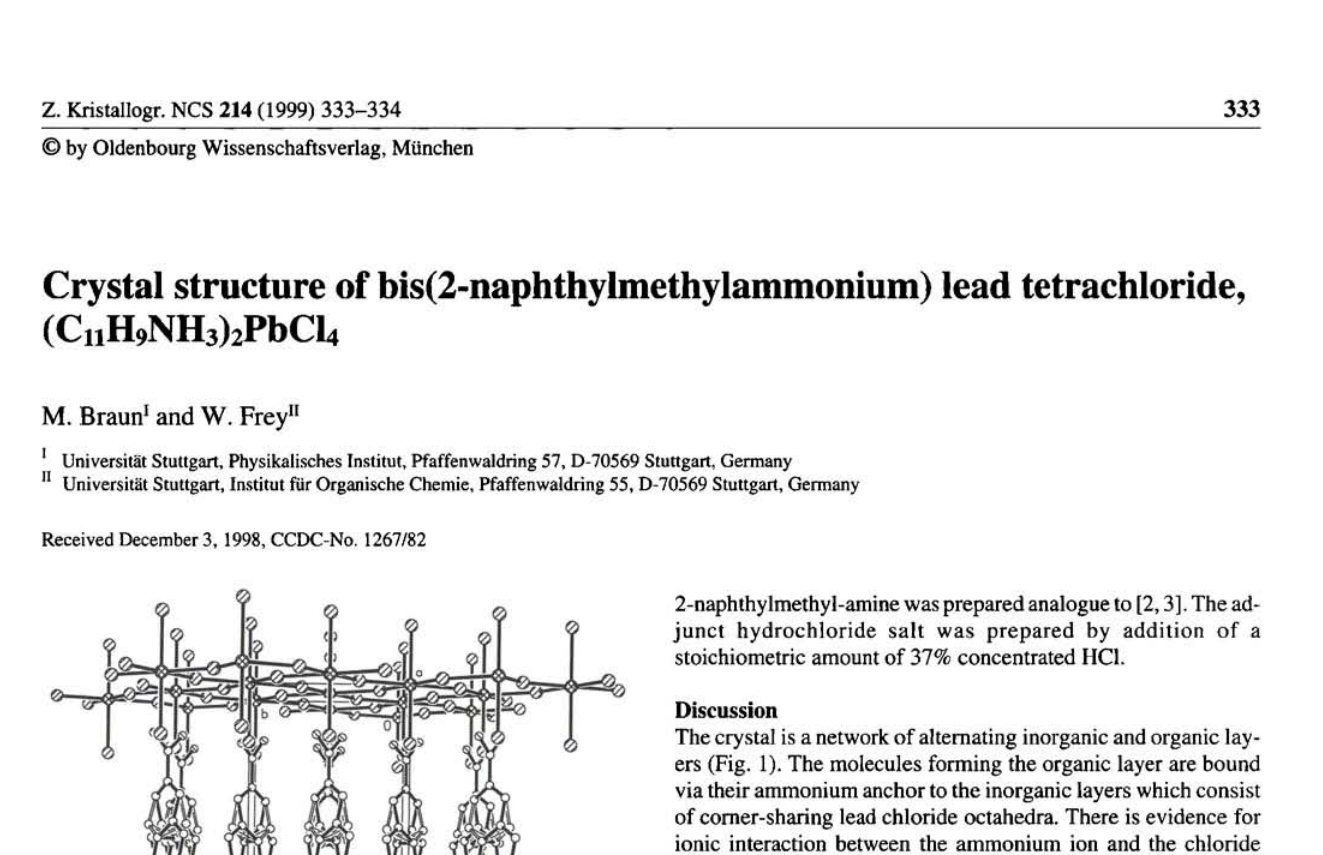
Fig. 1. Organic and inorganic layers in the (Cj iH9NH3)2PbCl4 structure.